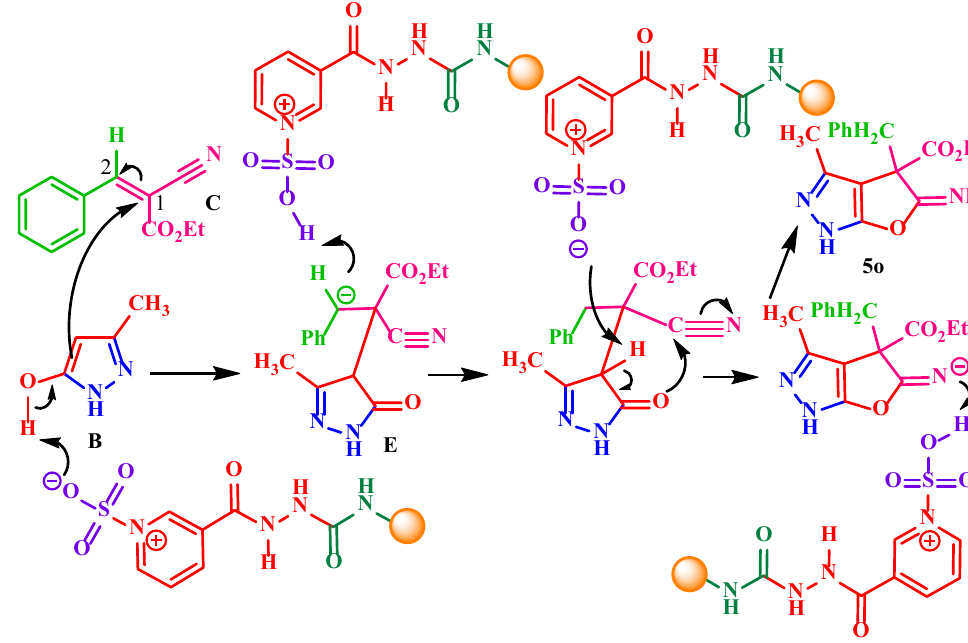
Figure 16. The proposed mechanism for the synthesis of the desired pyrazole 5o .